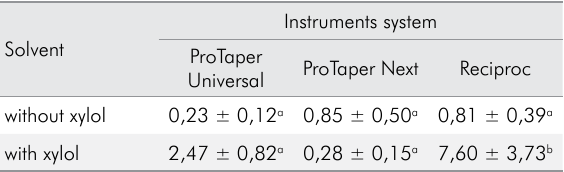
Table 1. Means and standard deviations of the volume (mm 3 ) of the remaining gutta-percha in the root canal wall.